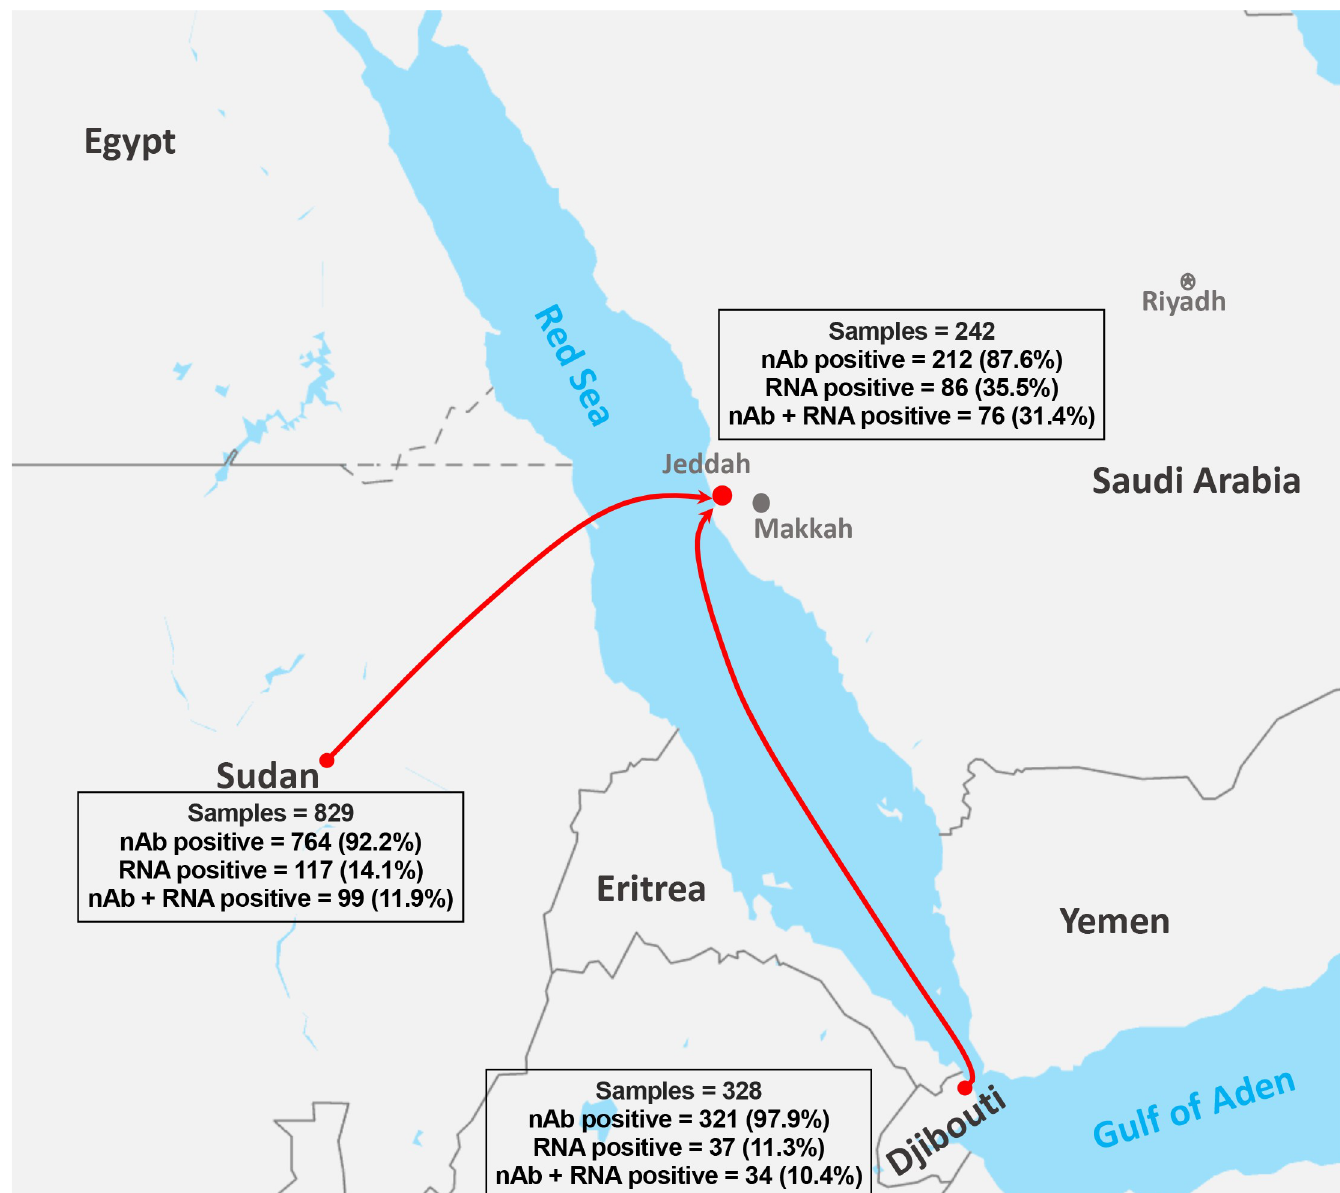
Fig 1. Map of source of collected samples from imported and local dromedary camels. Results from each source is shown as number and percentage of detected nAbs and viral RNA.